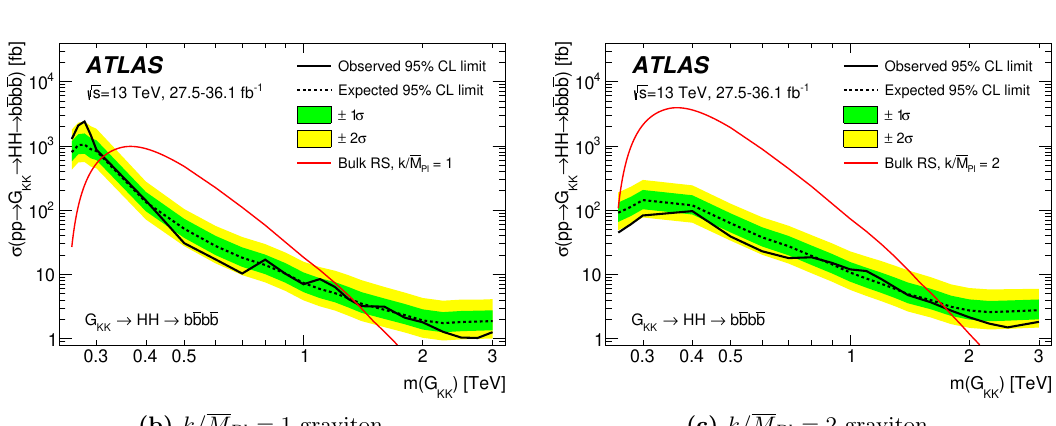
largest local excess is obtained from unconditional (cid:12)ts to all signal mass points and all three signal models. A distribution of those local signi(cid:12)cances is sampled, and the global p value is computed by counting how often the largest excess in the pseudo-experiments is 0 more signi(cid:12)cant than that observed in the data. The global signi(cid:12)cance obtained is 2 : 3 (cid:27) . Upper limits on the cross section are set in each of the benchmark models. Figure 9 shows the combined 95% CL upper limits for a narrow-width scalar and a spin-2 G the bulk Randall-Sundrum (RS) model with k=M sections are shown for the graviton models, taken from ref. [36]. The bulk RS model with k=M = 1 is excluded for masses between 313 and 1362 GeV, and the bulk RS model with Pl k=M = 2 is excluded for masses below 1744 GeV. The limits at low mass are stronger Pl for the wider Graviton than the narrow Graviton model, because in the former case the signal has a larger acceptance and the distorted shape peaks at higher values of m a steeply falling